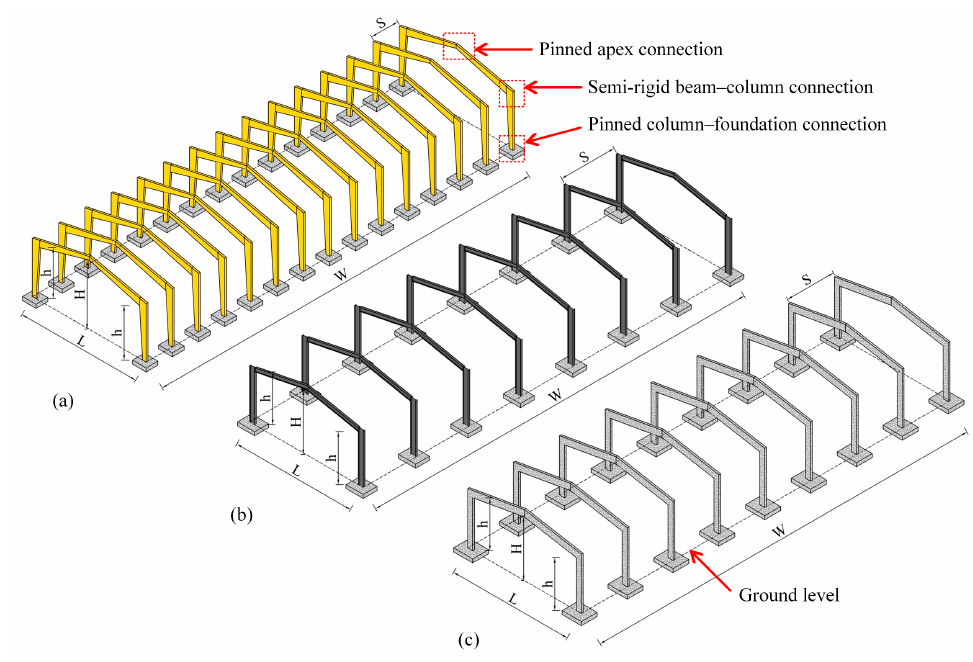
Figure 1. 3D drawing of the portal frames: ( a ) timber frames; ( b ) steel frames; ( c ) reinforced concrete frames.